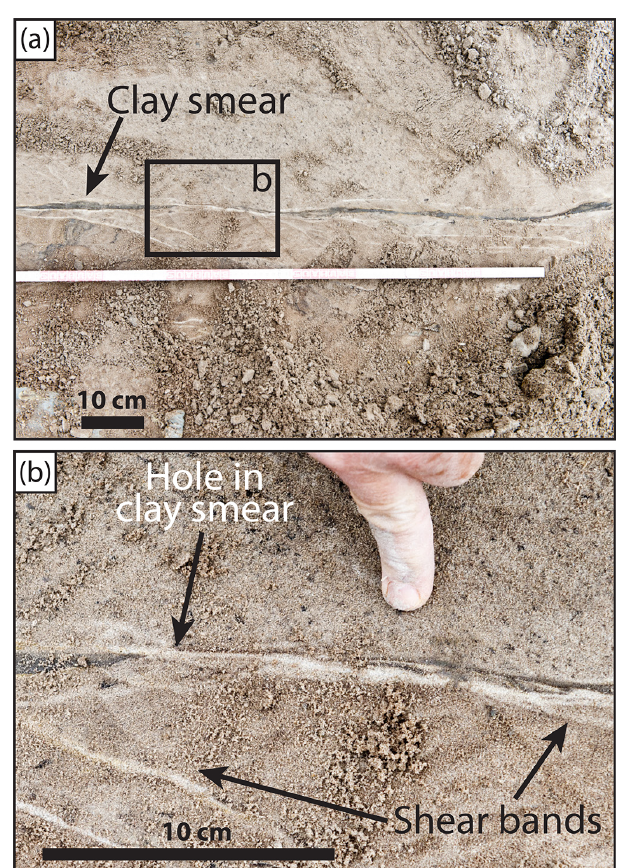
Figure 22. Hole in a clay smear in a horizontal profile due to cross-cutting shear bands: (a) overview photograph, (b) detail of (a) showing the hole at the cross-cutting shear